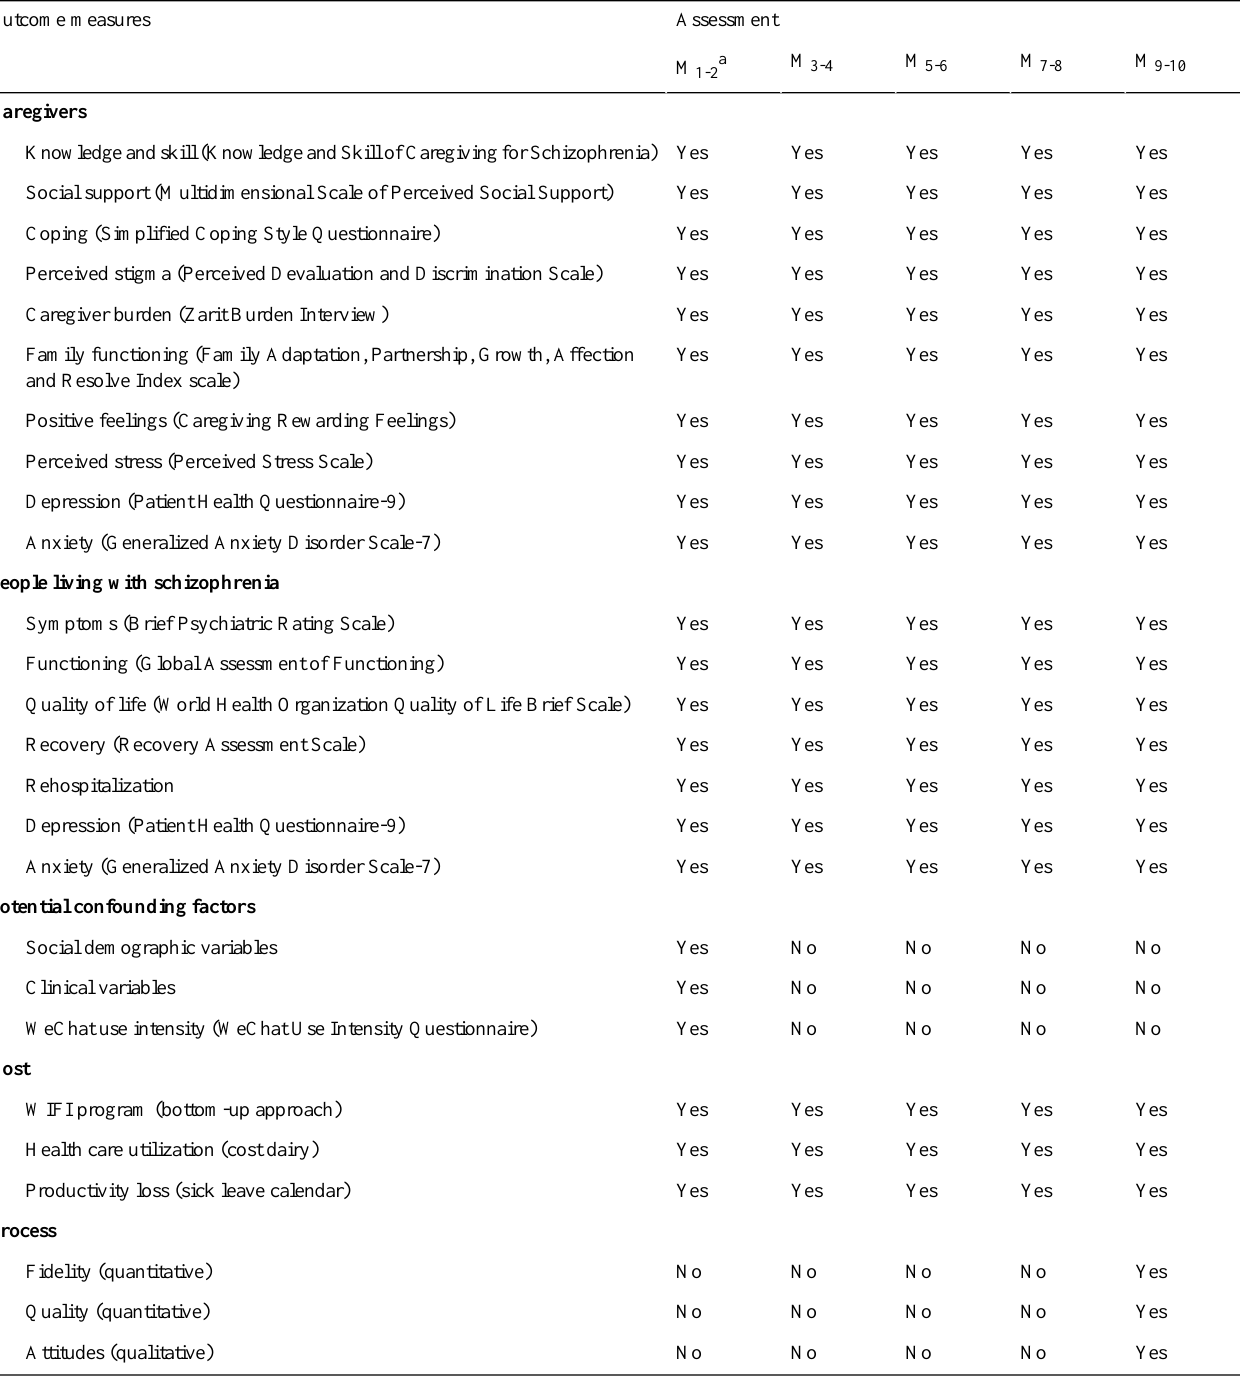
Table 3. Assessment of study